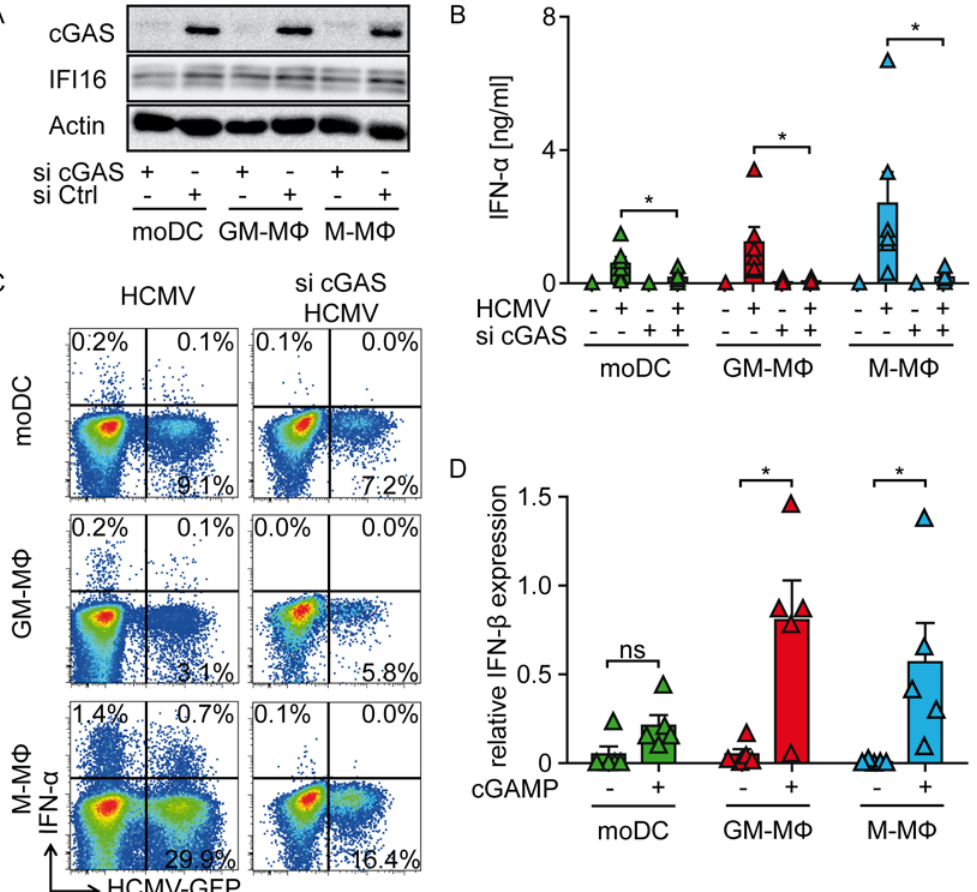
Fig 7. HCMV infected monocyte-derived DC and M Φ mount IFN- α responses in a cGAS-dependent manner. (A) moDC, GM-CSF M Φ , and M-CSF M Φ were transfected with siRNA directed against cGAS or control siRNA and cGAS or IFI16 expression was monitored by western blot analysis, while actin was used as loading control. Untreated or siRNA-mediated cGAS knock-down moDC, GM-CSF M Φ , and M-CSF M Φ were infected with HCMV-GFP at MOI 3 for 24 h and (B) IFN- α contents of cell-free supernatants were monitored by ELISA or (C) IFN- α + and/or HCMV-GFP + cells were analyzed by flow cytometry. (D) cGAS knock-down moDC, GM-CSF M Φ , and M-CSF M Φ were mock transfected or transfected with synthetic cGAMP and analyzed for IFN- β mRNA expression relative to HPRT1 mRNA by qPCR. Mean ± SEM of 6 (B) and 5 (D) or representative for 6 (A, C) different donors from 3 independent experiments. ns = not significant, * : p (cid:1) 0.04 one-tailed Wilcoxon signed rank